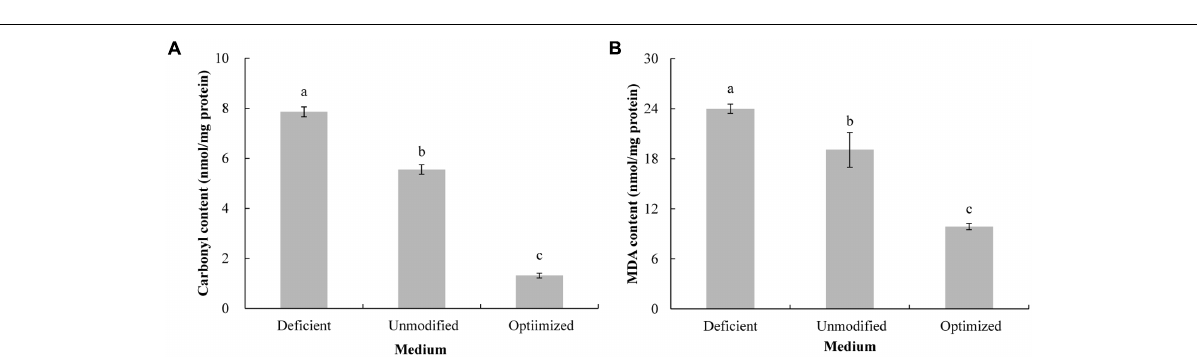
FIGURE 3 | Protein carbonylation (A) and lipid peroxidation (B) in yeast cells of C. diversa after 96-h culture in three different media: unmodified MM medium, ion-deficient MM medium, and Mg 2 + , Fe 2 + , and Zn 2 + optimized MM medium. Data represent the mean ± SD of the pooled data from three experiments ( n = 9). Columns with different letters indicate significant differences according to a Duncan’s multiple range test ( P <